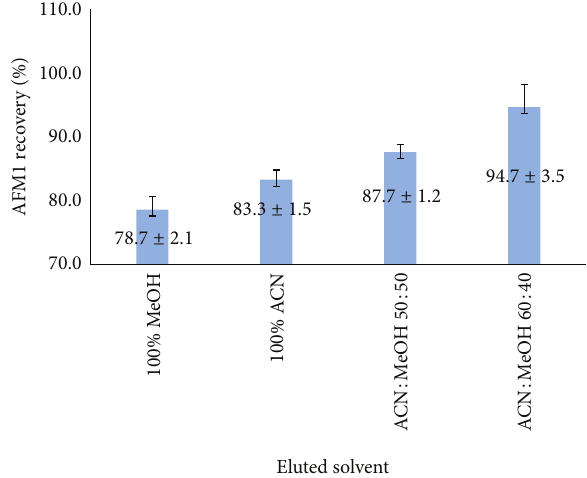
Figure 4: Selection of eluted solvent of methanol- (MeOH-) acetonitrile (ACN) for spiked egg samples (mean ± SD, 𝑛 = 3 , and SD expressed by error bars) at a level of 0.05 𝜇 g/kg.